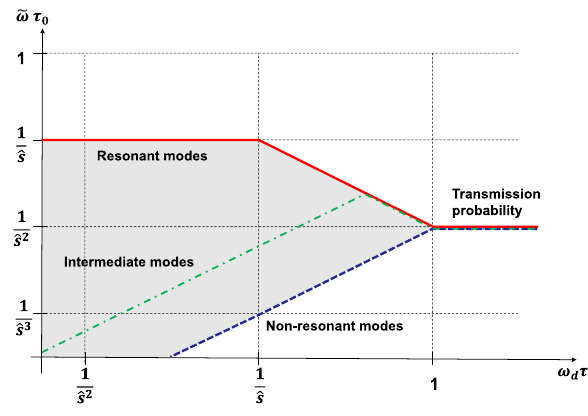
Fig. 3 The normalised rate of tunnelling depending on the normal- ised characteristic decoherence rate for different